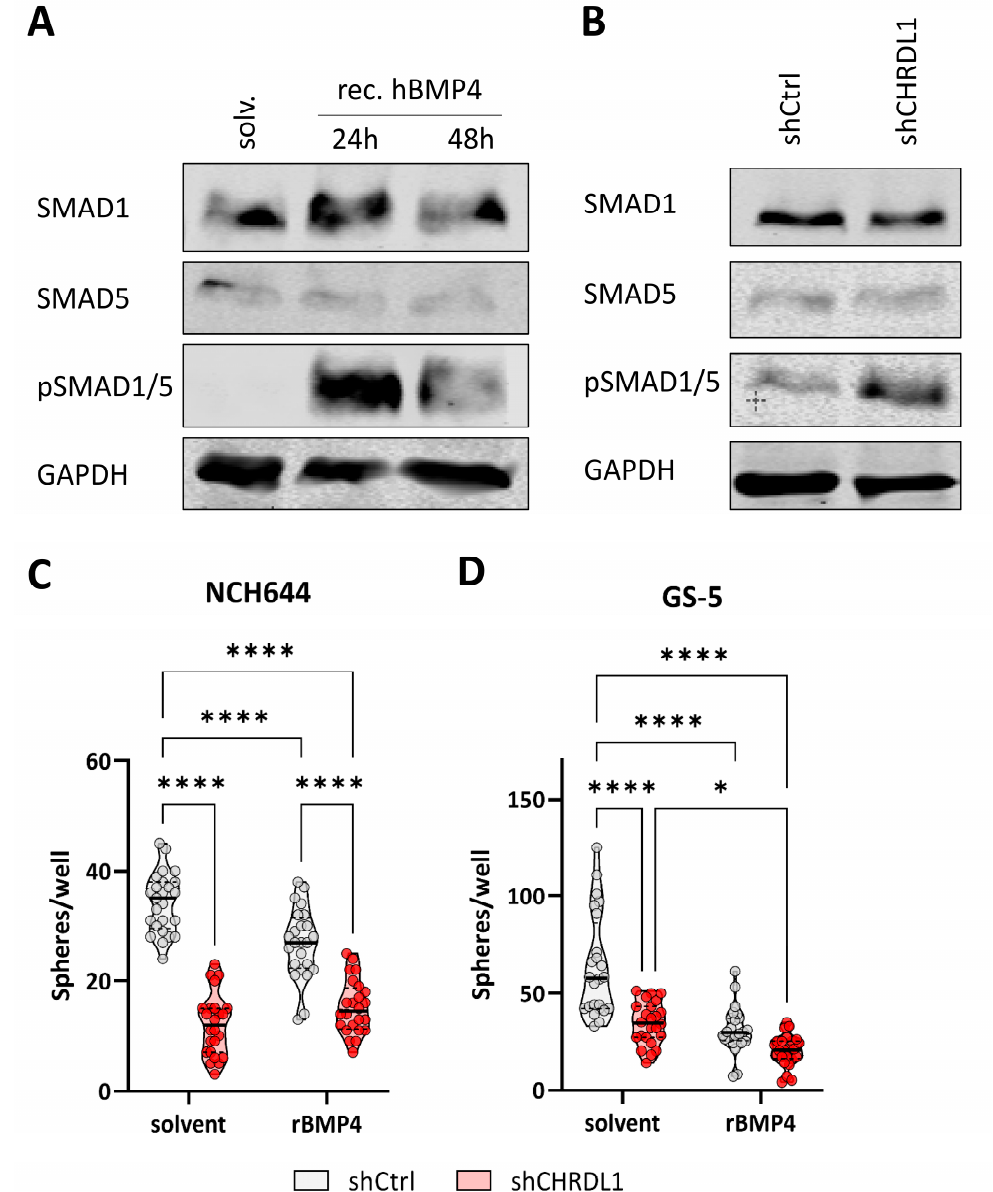
Figure 6. CHRDL1-depletion activates BMP4-signaling. ( A , B ) Western Blot of ( A ) NCH644 treated with 20 ng/mL recombinant human BMP4 for 24 or 48 h or ( B ) NCH644 shCtrl and shCHRDL1. ( C , D ) Sphere formation assay of ( C ) NCH644 and ( D ) GS-5 shCtrl or shCHRDL1 GSCs and treatment with 25 ng/mL recombinant BMP4 or solvent for 7 days after seeding of 500 and 1000 cells per well. * p < 0.05; **** p < 0.0001; two-way-ANOVA with Sidak’s multiple comparison tests; white dot: shCtrl, red dot: shCHRDL1.